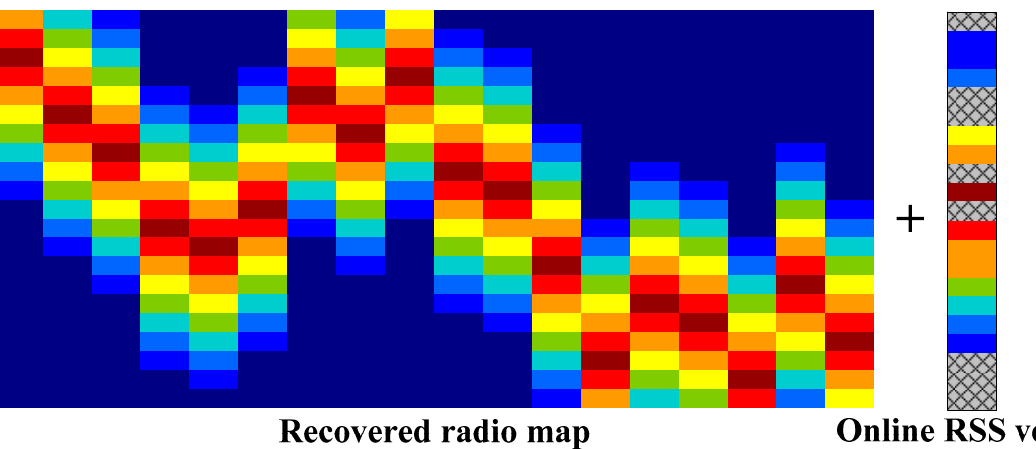
Figure 6. An example of recovering the online RSS reading